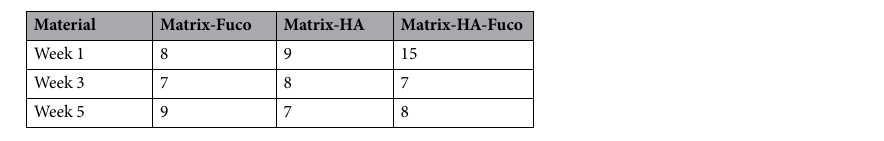
Table 2. Number of samples used per group and per time-point for ex vivo micro-CT